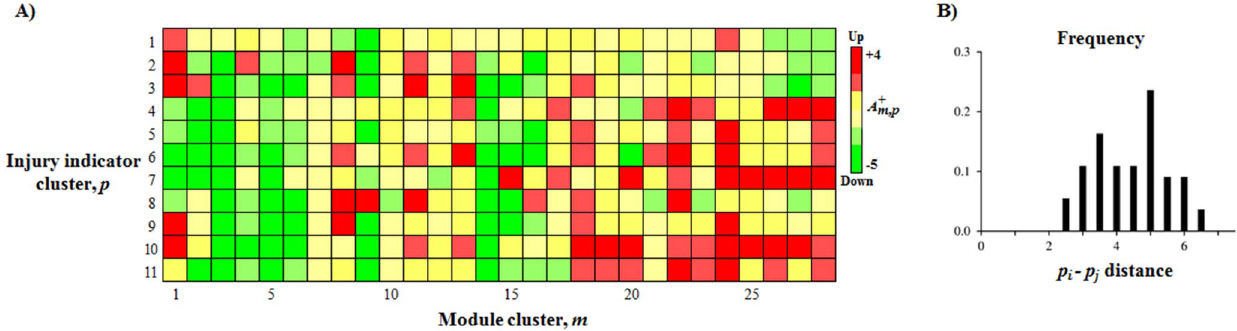
Figure 5. Activation pattern of module clusters. 5A ) Reduced representation of the each module cluster’s activation patterns for the injury indicators shown in Figures 3 and 4 . The illustration highlights the differences and similarities of each injury indicator based on their module activation patterns. 5B ) Shows the root-mean-square distance between all unique injury-indicator cluster pairs calculated using the averaged activation scores A